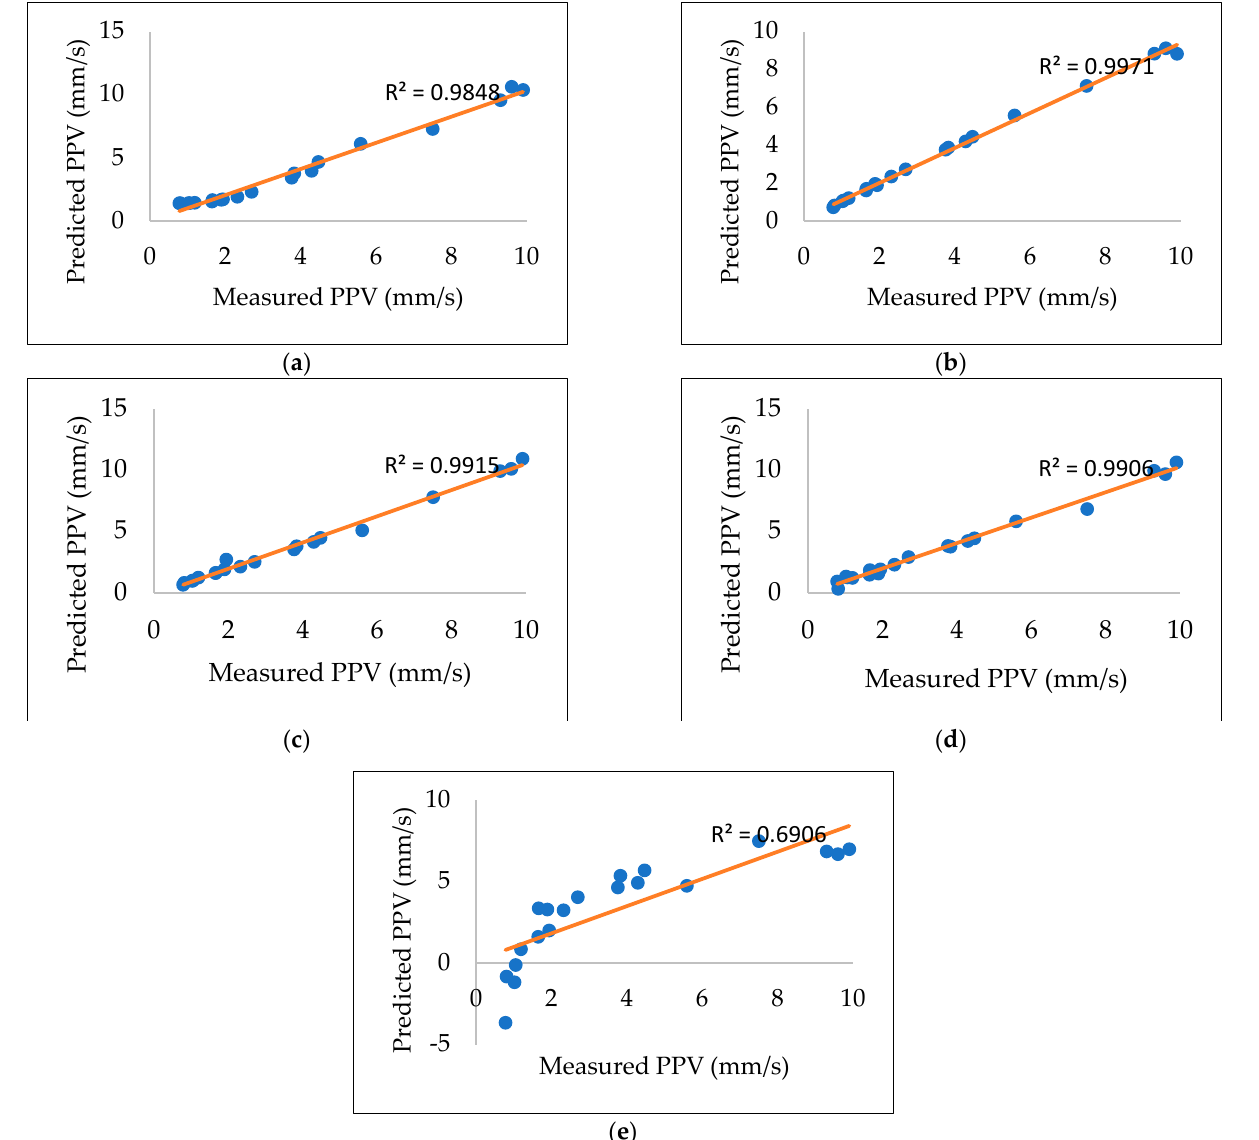
Figure 7. Comparison of Predicted and Measured PPV for: ( a ) BPNN ( b ) GPR ( c ) ELM ( d ) MARS ( e ) MVRA.